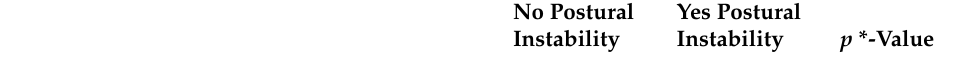
Table 1. Clinical characteristics of patients without postural instability and with postural